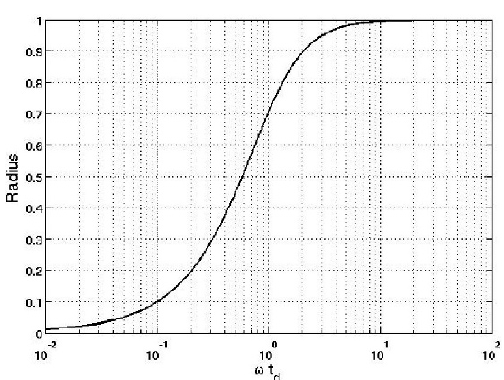
Figure 2. Radius of the phase diagram versus ωt